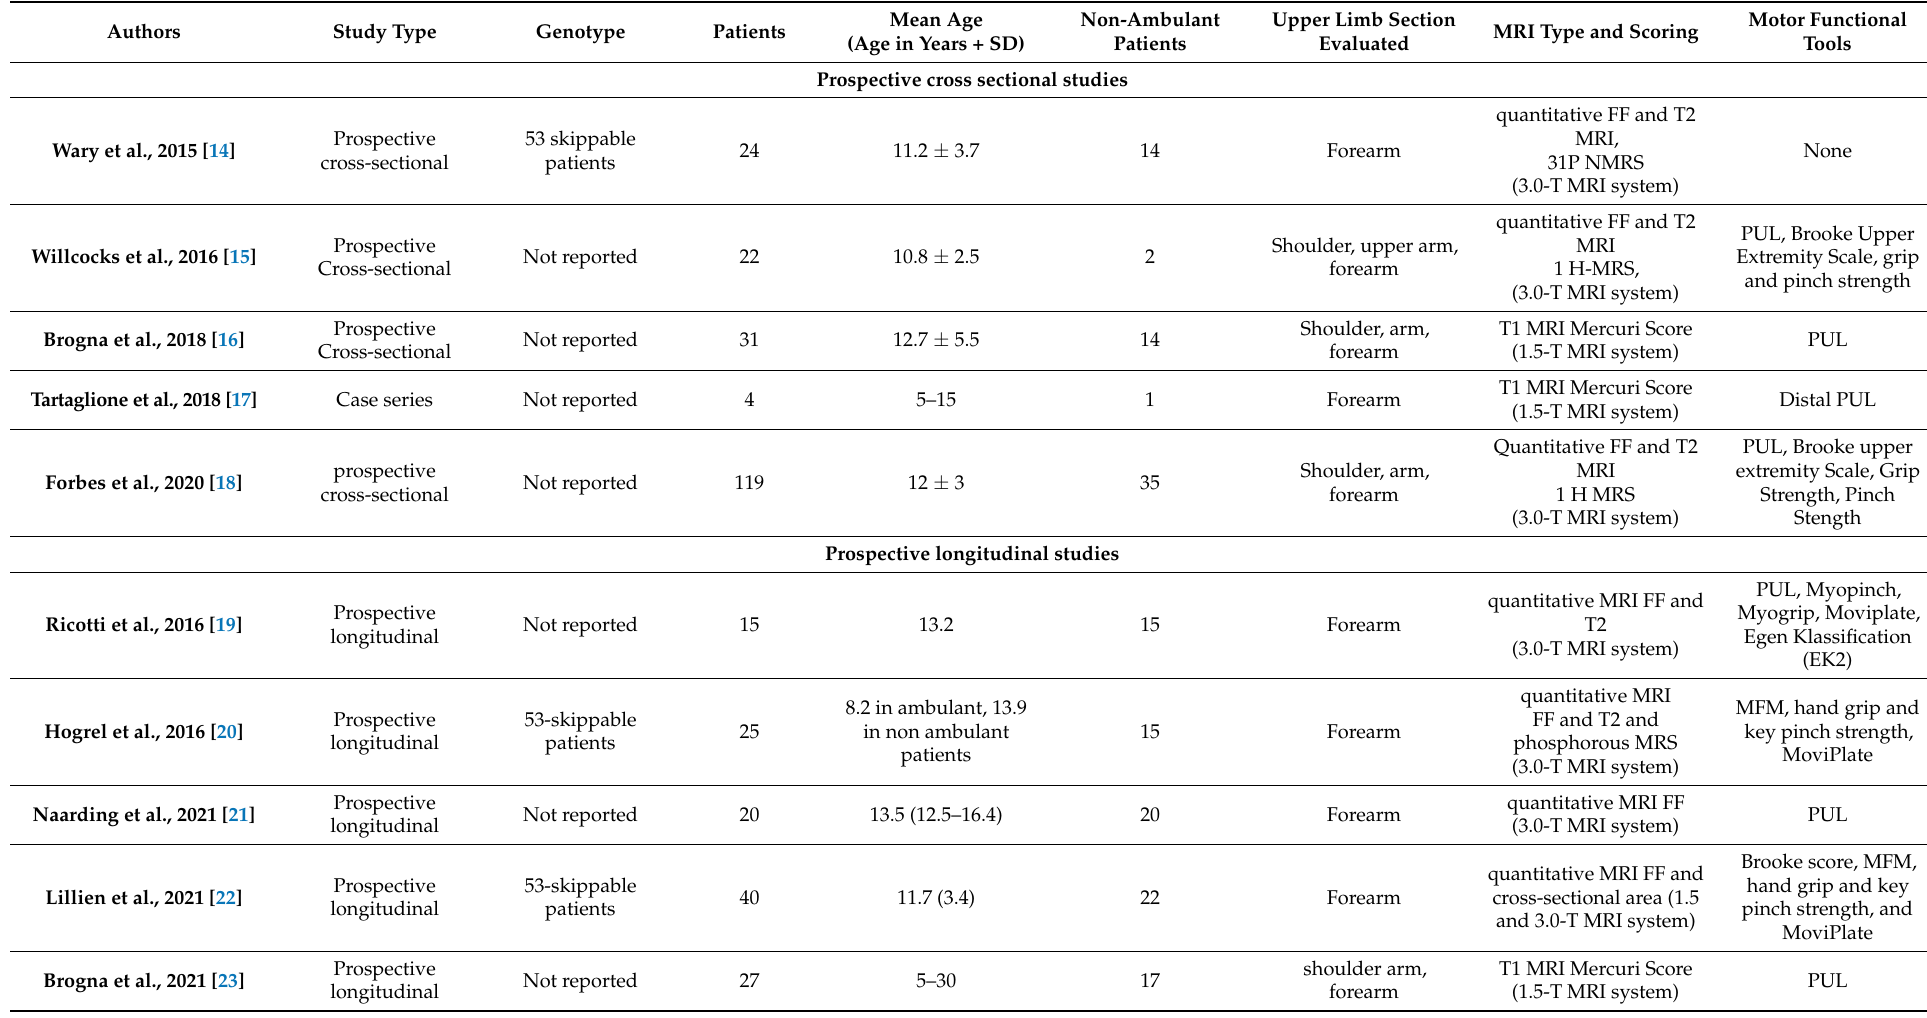
Table 1. List of prospective and longitudinal studies